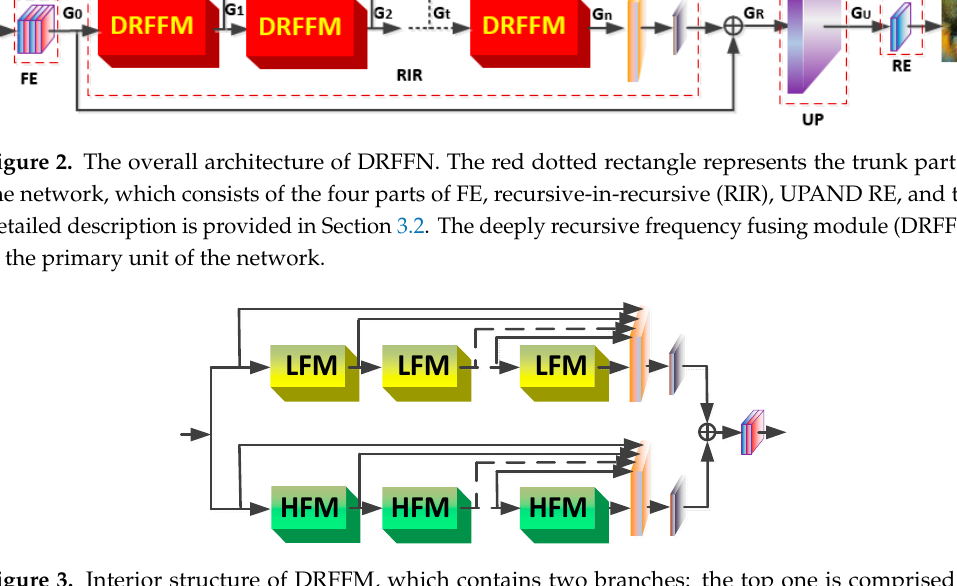
Figure 3. Interior structure of DRFFM, which contains two branches: the top one is comprised of low-frequency models (LFMs), and the bottom one is composed of high-frequency modules (HFMs).